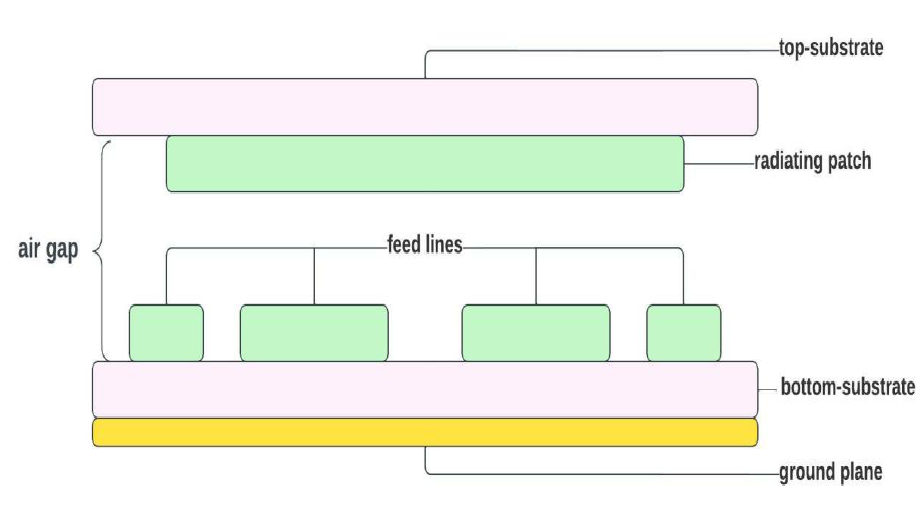
Figure 20. The structure of the proposed antenna. Figure 22. Structure of an antenna with two layers of substrates (proximity couple fed) [289]